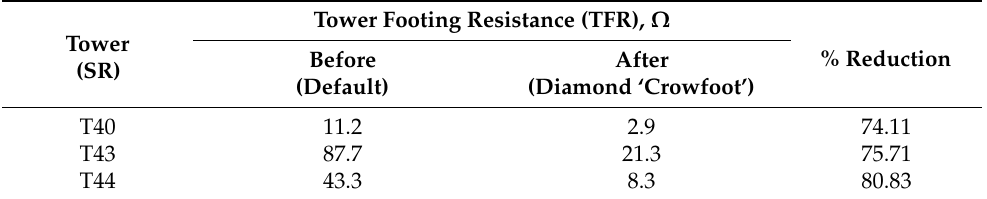
Table 6. The % reduction in the TFR value before and after improvement.